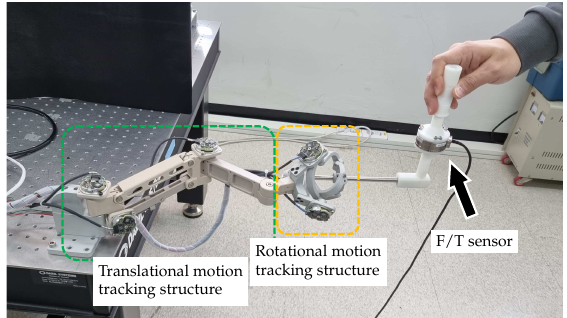
Figure 15. Experimental setup to evaluate back-drivability.